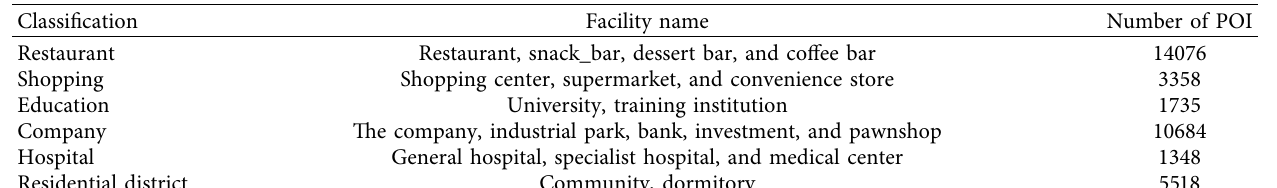
Table 3: POI data classifcation in Beijing.